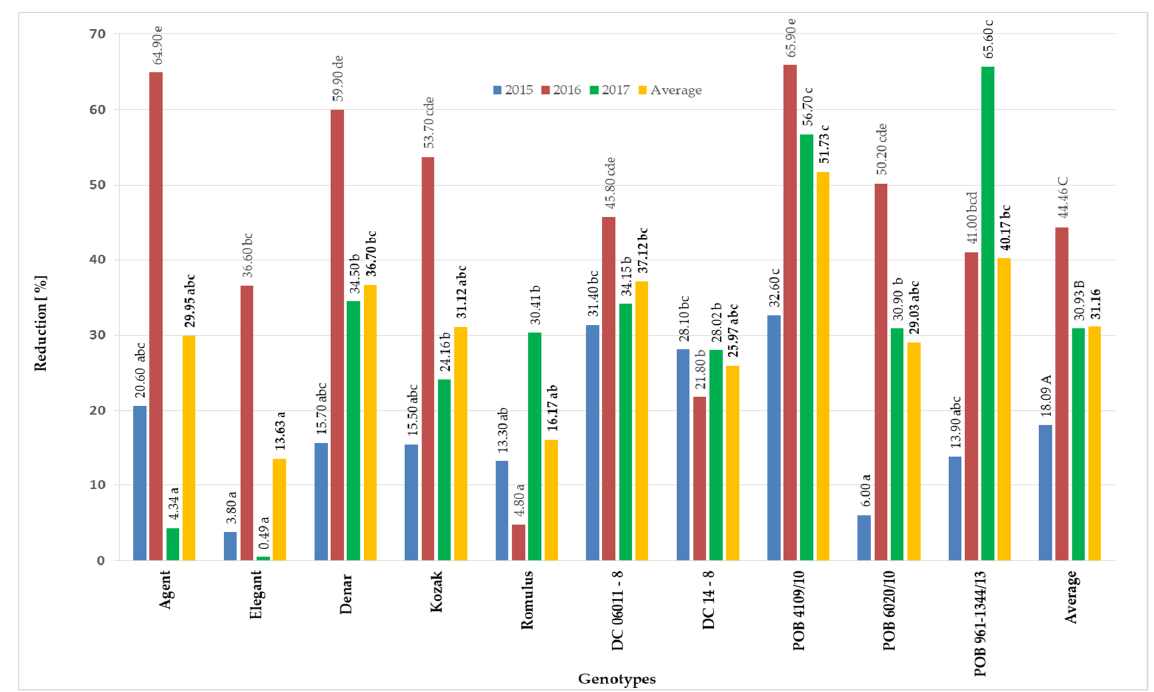
Figure 3. Reduction in the kernels number per panicle after inoculation with F. equiseti compared to control. The values obtained within an individual year for all genotypes, marked with the same letter do not differ significantly at p ≤ 0.05. The average values obtained for all genotypes over the three years of study (yellow columns), marked with the same letter, do not differ significantly at p ≤ 0.05.